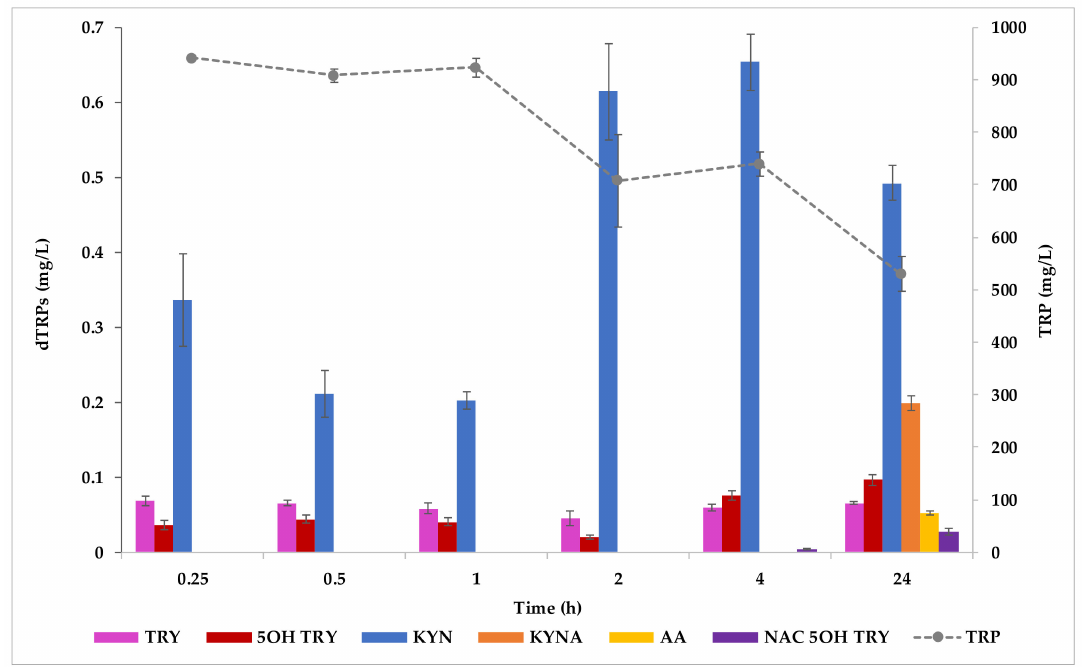
Figure 6. TRP derivatives produced by S. cerevisiae EC1118 in WCB experiments. Error bars indicate the standard deviation among the mean values of biological replicates.